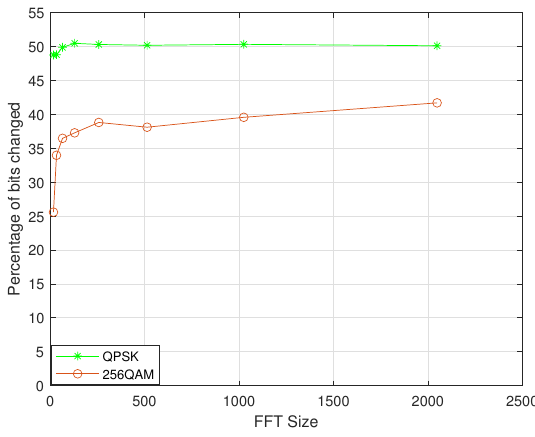
Figure 8. Independence test results.